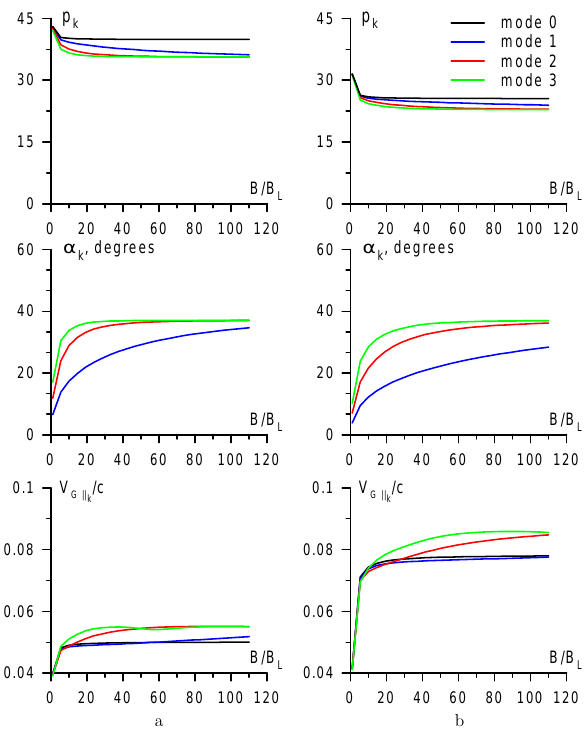
Fig. 4. Dependencies of eigenmode parameters on the coordinate along the duct (parameterized by magnetic field value) for differ- ent frequencies: a − ω/ω BL = 0 . 14, b − ω/ω BL = 0 . 35; the same leg- end as in Fig. 2 is used; other parameters: κa = 5, ω p = 1 . 25; subscript L refers to the values at the equatorial ω p /ω p ∞ d region.